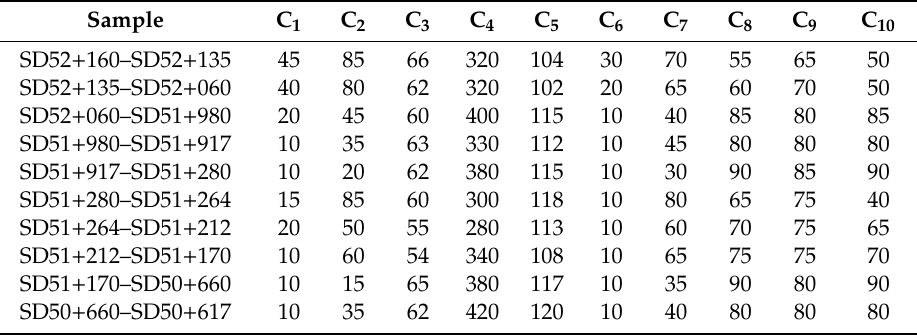
Table 4. The risk factor parameter values of water inrush in the SS (Shuang-san) tunnel. Sample